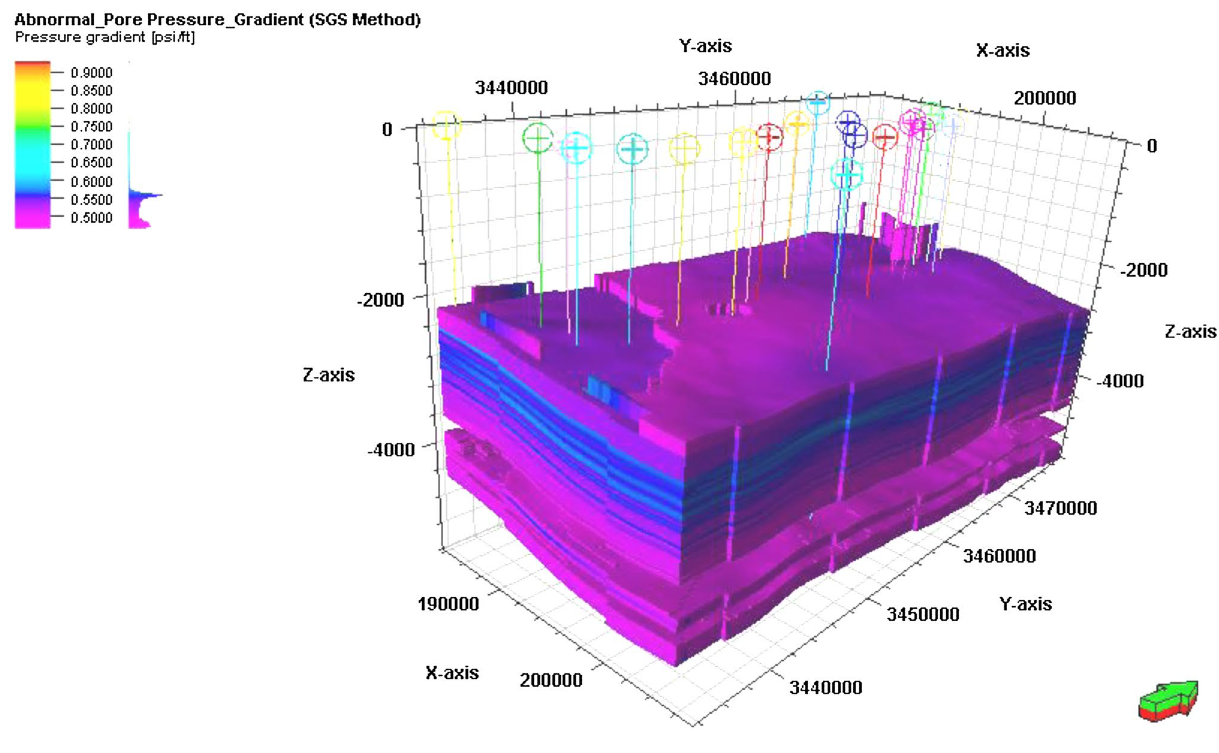
Fig. 11 Area with higher than normal pore pressure by SGS method in the studied